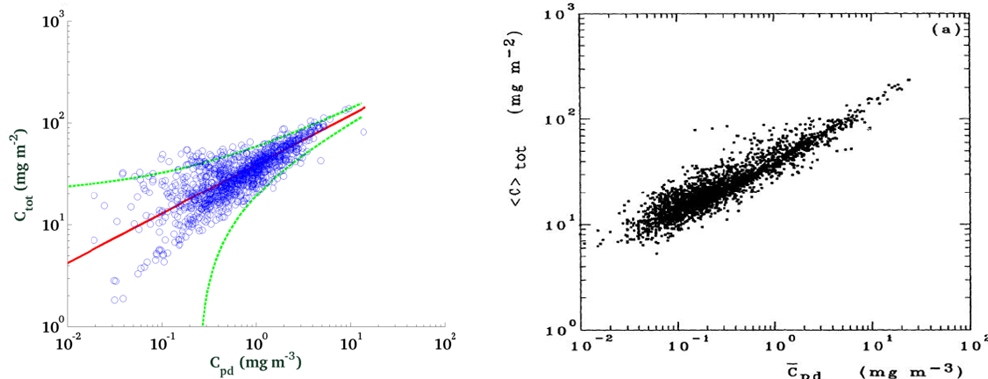
Fig. 1. Total chlorophyll content within the euphotic layer ( C tot ) versus mean chlorophyll within the surface layer ( C pd ) . Left: for the Greenland Sea, this study, R = 0.84, N = 1199, significant correlation ( p < 0.0001). The red line is the regression line (Eq. 3), and green lines are the 95% confidence intervals. Right: from the global study by Morel and Berthon (1989), copyright (1989) by the Association for the Sciences of Limnology and Oceanography,